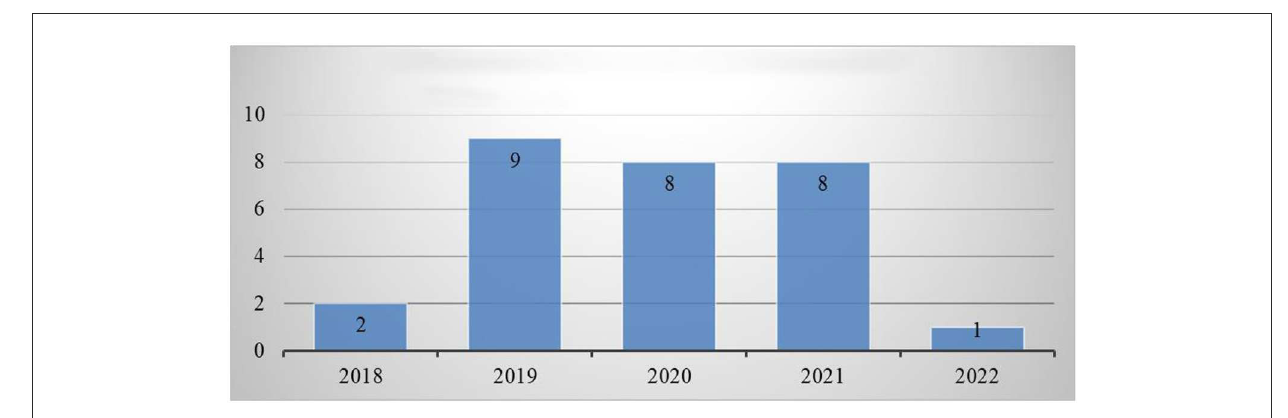
FIGURE3 Number of articles based on year of